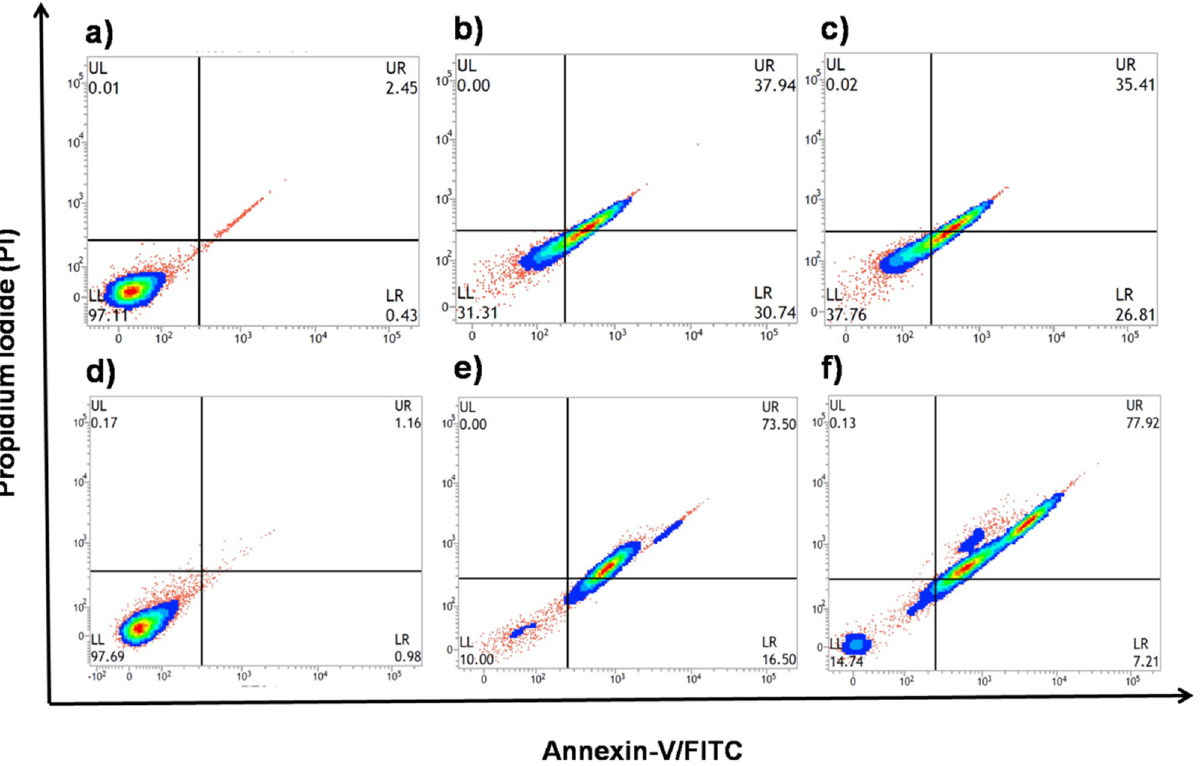
Figure 7. Effect of gold nanoconjugates in the presence of 5-ALA mediated PDT targeting MCF-7 (a-c) and MDA-MB-231 ( d – f ) breast cancer cells. ( a ) Control (untreated cells). ( b ) IR-5-ALA-TPP-CTAC©AuNTs (IC 50 – 0.71 ± 0.14 µg/mL). ( c ) IR-5-ALA-TPP-PSS@CTAC©AuNTs (IC 50 -0.67 ± 0.89 µg/mL). ( d ) Control (untreated cells). ( e ) IR-5-ALA-TPP-CTAC©AuNTs (IC 50 -0.78 ± 0.55 µg/mL). ( f ) IR-5-ALA-TPP-PSS@CTAC©AuNTs (IC 50 -0.58 ± 0.23